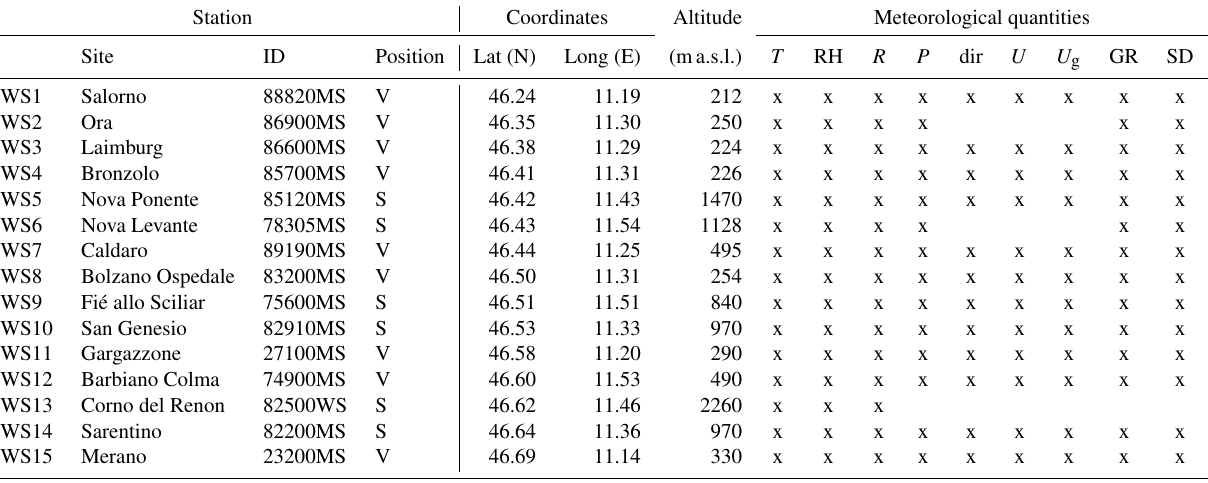
Table 1. Surface weather stations (WSs) adopted to monitor the meteorological field during BTEX along with their position (V: valley floor station; S: valley sidewall station), coordinates, altitude and available measurements: air temperature ( T ); relative humidity (RH); rain ( R ); atmospheric pressure ( P ); wind direction (dir); wind intensity ( U ); wind gust ( U g ); global radiation (GR); and sunshine duration (SD). The first column indicates the label of the station shown in Fig. 1.